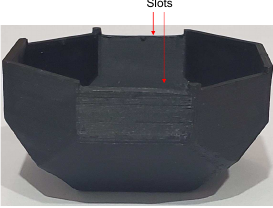
Figure 10. Slots in one-half of the polyhedron to hold and level the test bench.